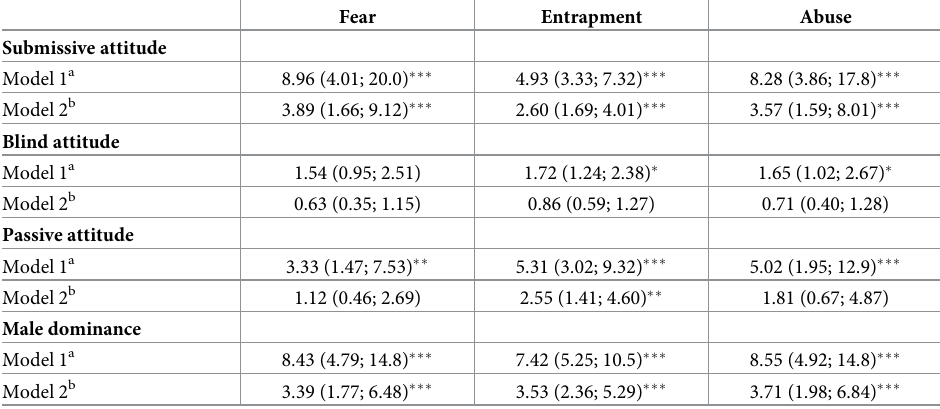
Table 3. Adjusted odds ratios (95% CI) for the association between GRs and the perception of fear, entrapment and abuse (n = 1,005). Fear